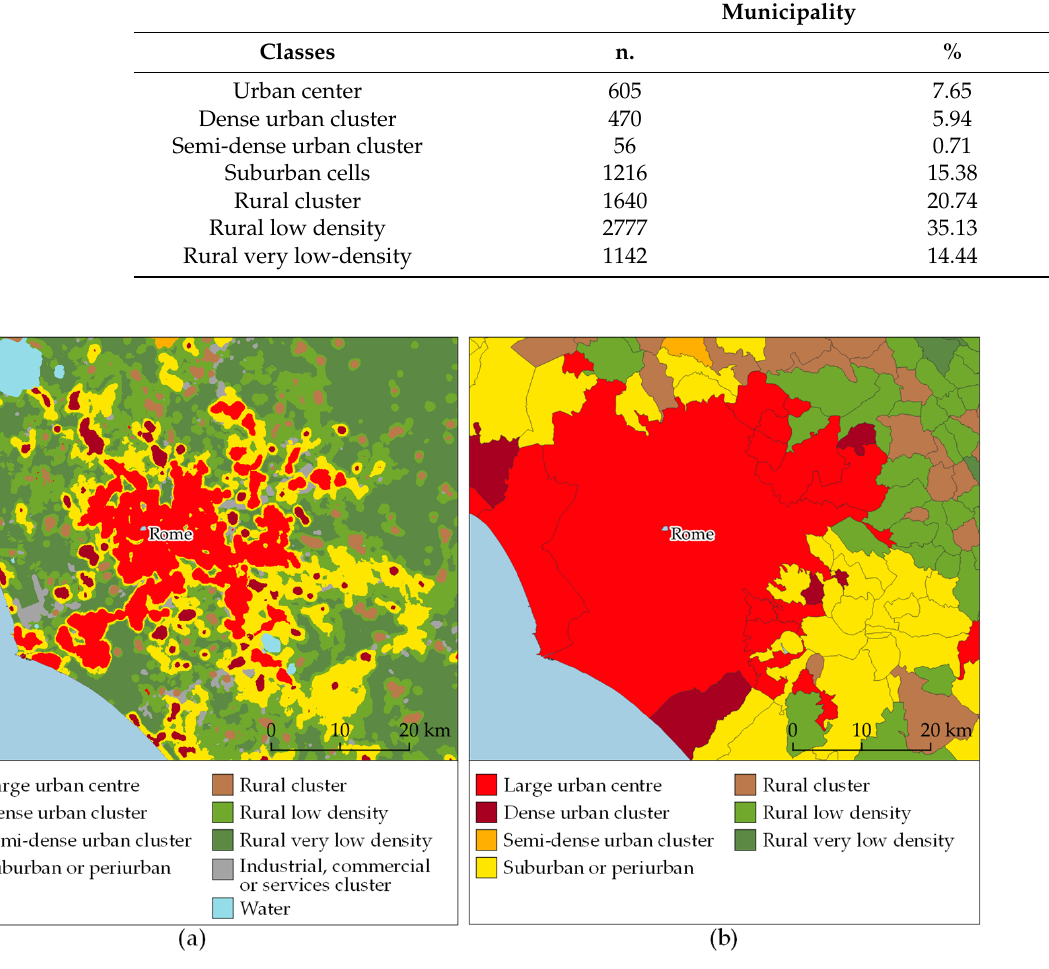
Figure 6. The metropolitan area of Rome. ( a ) Urban–rural continuum classes. ( b ) Attribution of the prevailing urban–rural class to the municipalities. This generalization involves a loss of detail, which precludes the possibility of using indicator 11.3.1 for intra-municipal analyses, but it is the only way to exploit ISTAT demographic data, which have annual updates at the most at the municipal level.